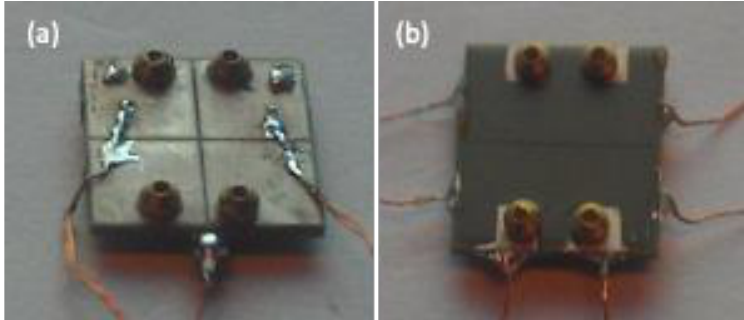
Figure 10. Fabricated stators. ( a ) Simple bimorph and ( b ) multi-layer bimorph.